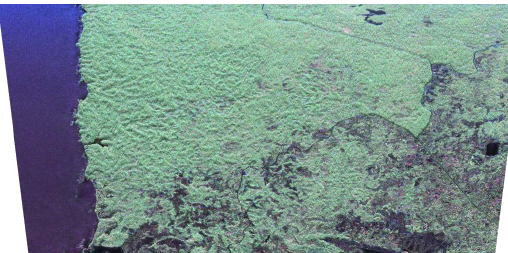
Figure 1. P-band PolInSAR image in Pauli basis in Mondah test site